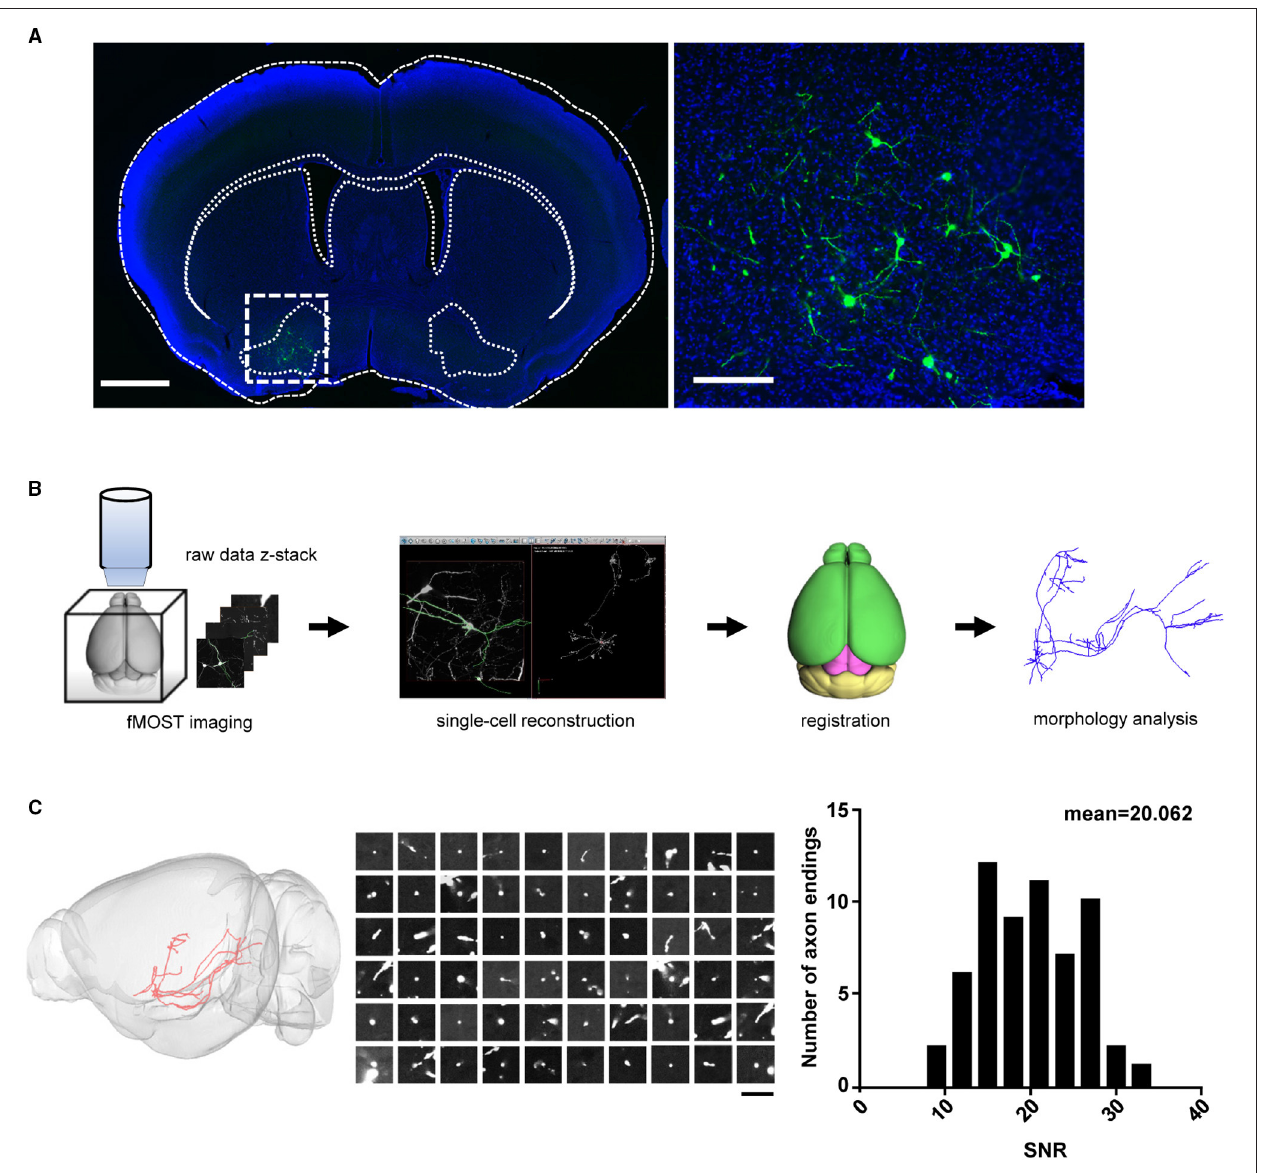
FIGURE 1 | Sparse labeling and whole-brain reconstruction of the VP neurons. (A) GFP expression (green) following the infusion of AAV-Cre into the MD and the Cre-dependent dual-AAV vectors into the VP. Left: coronal view of the brain section containing the VP (scale bar = 1mm). Right: zoom-in view of the dashed-box area in left (scale bar = 200 µ m). (B) Workflow of imaging and whole-brain reconstruction of individual neurons. (C) Distribution of SNR for the axon endings. The left panel shows the labeling of a single VP projection neuron. The middle panel shows the raw images of 60 randomly chosen axonal terminal endings for the SNR calculation (scale bar = 20 µ m). The SNR indicates the mean signal divided by the standard deviation of the background. The right panel shows the distribution histogram of the SNR values ( n = 60 axonal endings). The high SNR values indicated an abrupt ending that is consistent with strong terminal labeling. VP, ventral pallidum; MD, mediodorsal nucleus of thalamus; SNR, signal-to-noise